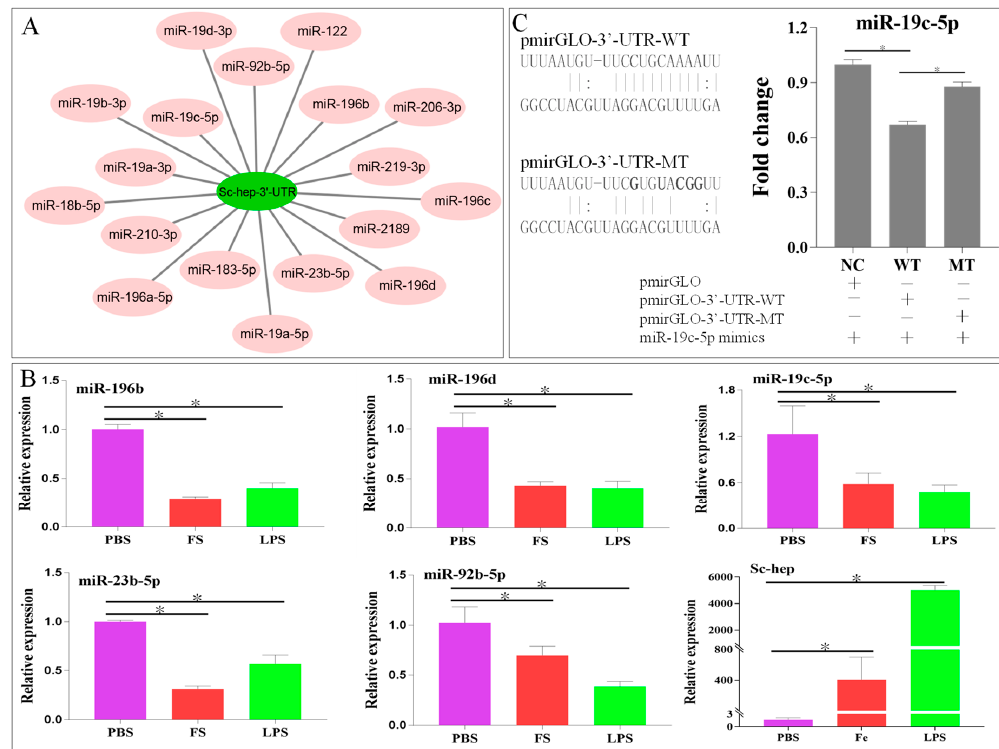
Figure 5. Identification of the targeting relationship between Sc-hep and miRNA. ( A ): Prediction of Sc-hep targeting by miRNA. ( B ): Expression of five miRNAs negatively correlated with Sc-hep expression. ( C ): A dual-luciferase reporter assay was performed to identify the targeting relationship between miR-19c-5p and Sc-hep . Statistical analysis results are expressed as means ± SEM; * represents p < 0.05, indicating significant differences between the groups.